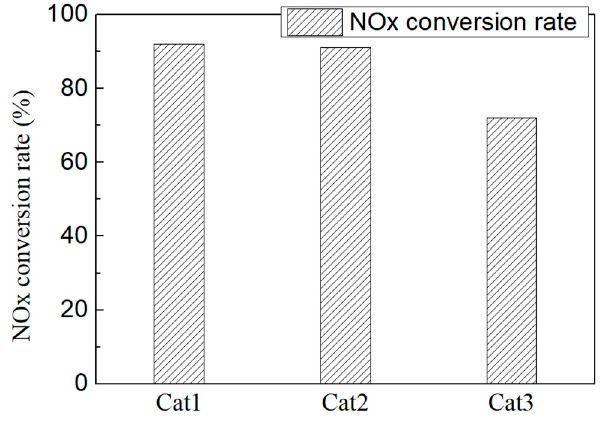
Figure 7. NOx conversion rates of the catalysts at AV 25 m/h and 340 °C.